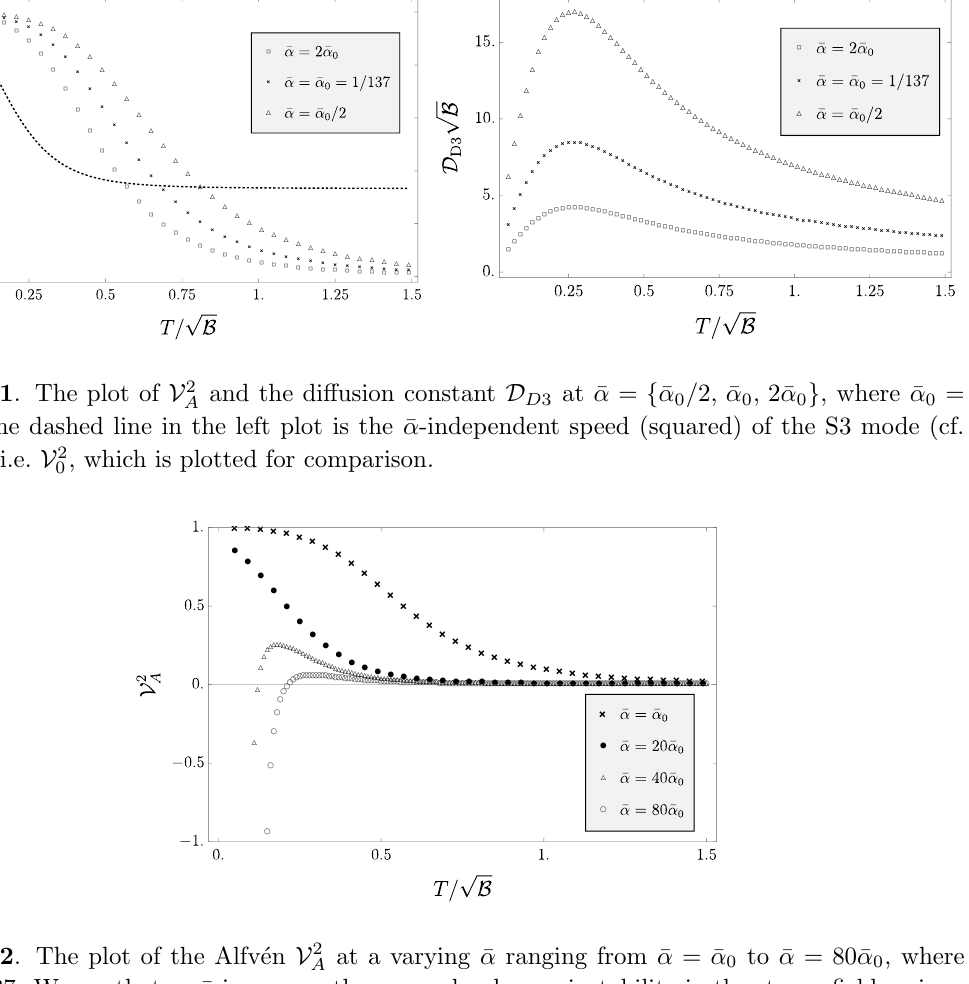
Figure 12 . The plot of the Alfv(cid:19)en V 2 at a varying (cid:22) (cid:11) ranging from (cid:22) (cid:11) = (cid:22) (cid:11) 0 to (cid:22) (cid:11) = 80(cid:22) (cid:11) 0 , where A (cid:22) (cid:11) 0 = 1 = 137. We see that as (cid:22) (cid:11) increases, the waves develop an instability in the strong-(cid:12)eld